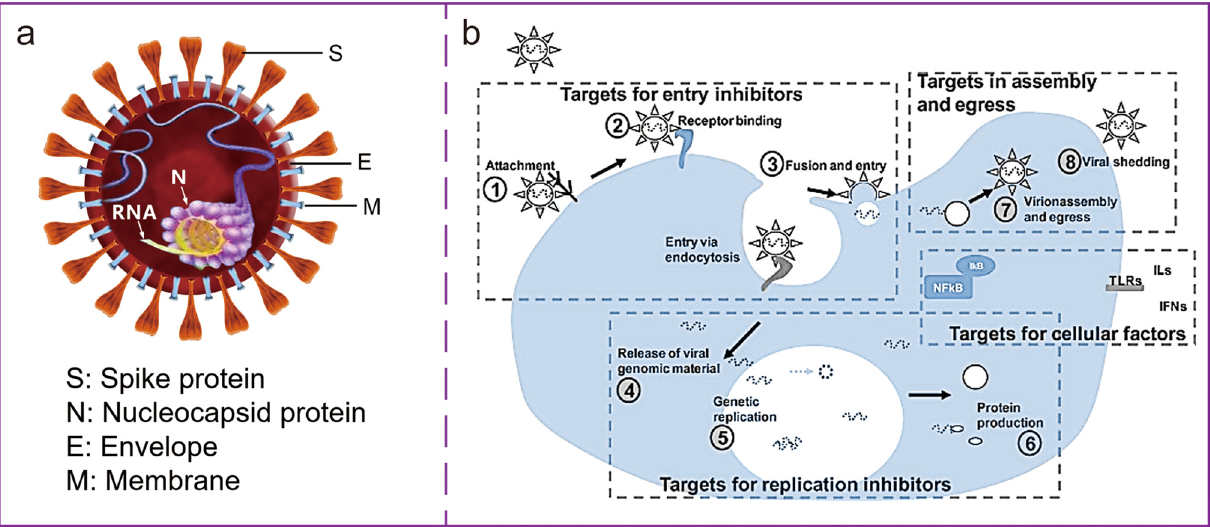
Figure 1: ( a ) Coronavirus structure diagram. ( b ) Major steps in the generalized viral life cycle. Potential targets for inhibitors of entry, replication, assembly, and egress and cellular factors [ 10 ]